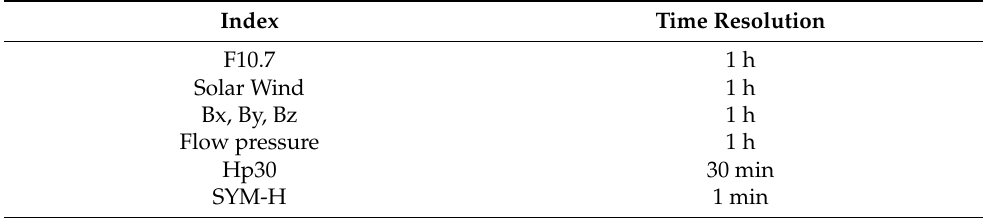
Table 1. Time resolution of space weather indices.